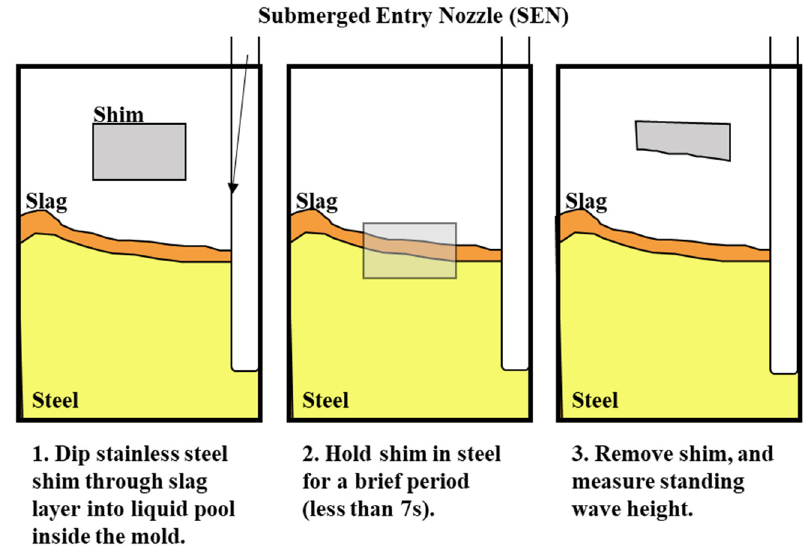
Figure 5. Shim dip test.